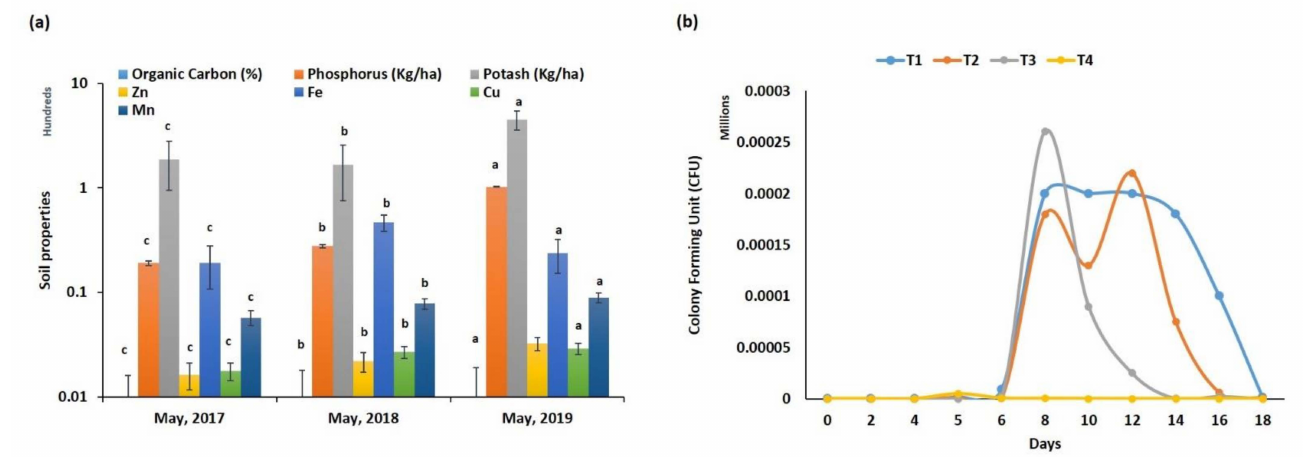
Figure 1. Effect of Jeevamrit on soil chemical and microbial counts. ( a ) Chemical properties of soil after Jeevamrit application for 3 successive years. Different letters indicate statistical difference shown in three successive years (2017 to 2019) with a p -value = 0.001. ( b ) Effect of different components of Jeevamrit on bacterial count in soil. T1 = Jeevamrit formulation, T2 = Jeevamrit without pulse flour, T3 = Jeevamrit without Jaggery, T4 = Jeevamrit without pulse flour and Jaggery.